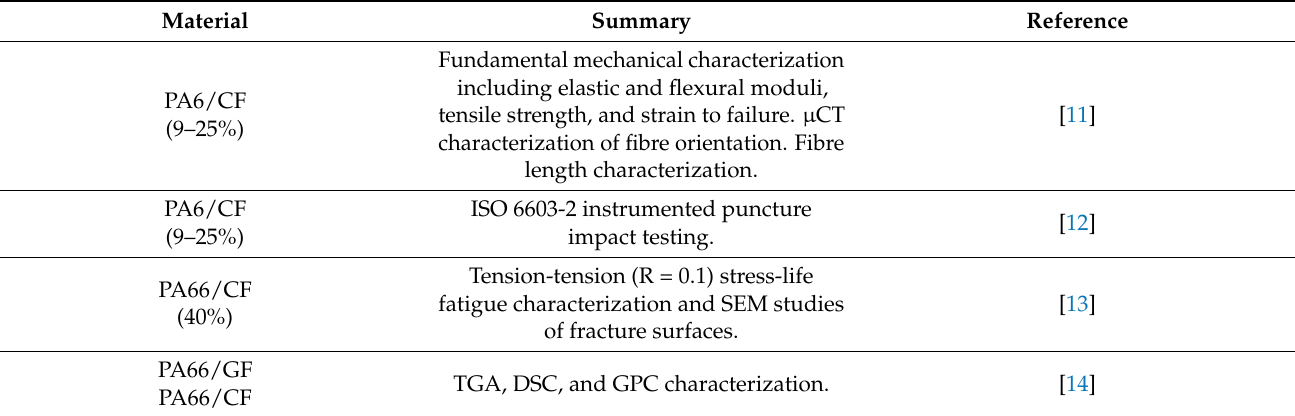
Table 2. Carbon-reinforced long fibre thermoplastic research by the International Composites Re- search